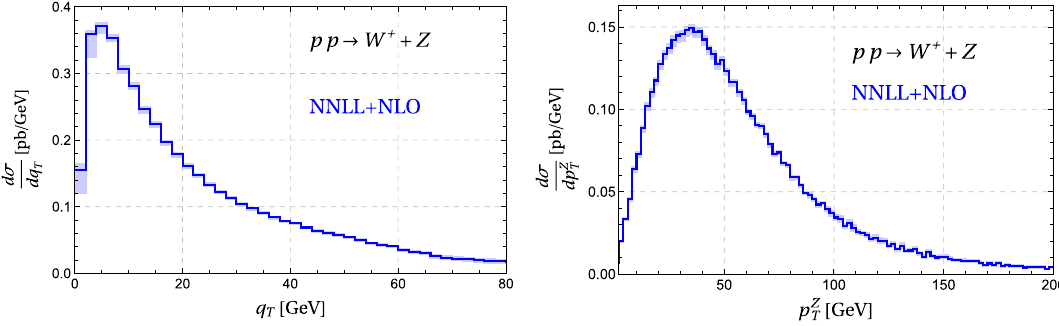
√ s = 7TeV. scale uncertainties. The only cut we apply is on the rapidity of the diboson system, which we restrict to | y | < 2 .